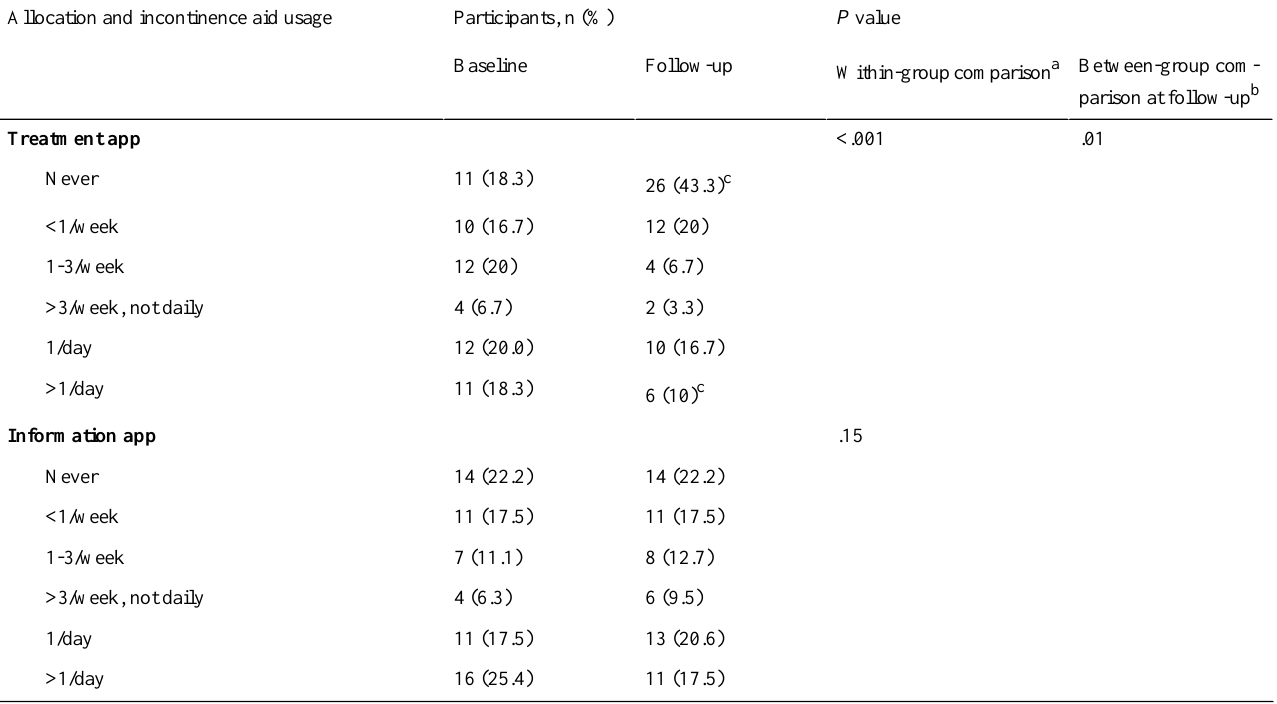
Table 5. Incontinence aid usage by participants in the treatment group (n=60) and information group (n=63), reported at baseline and at follow-up.